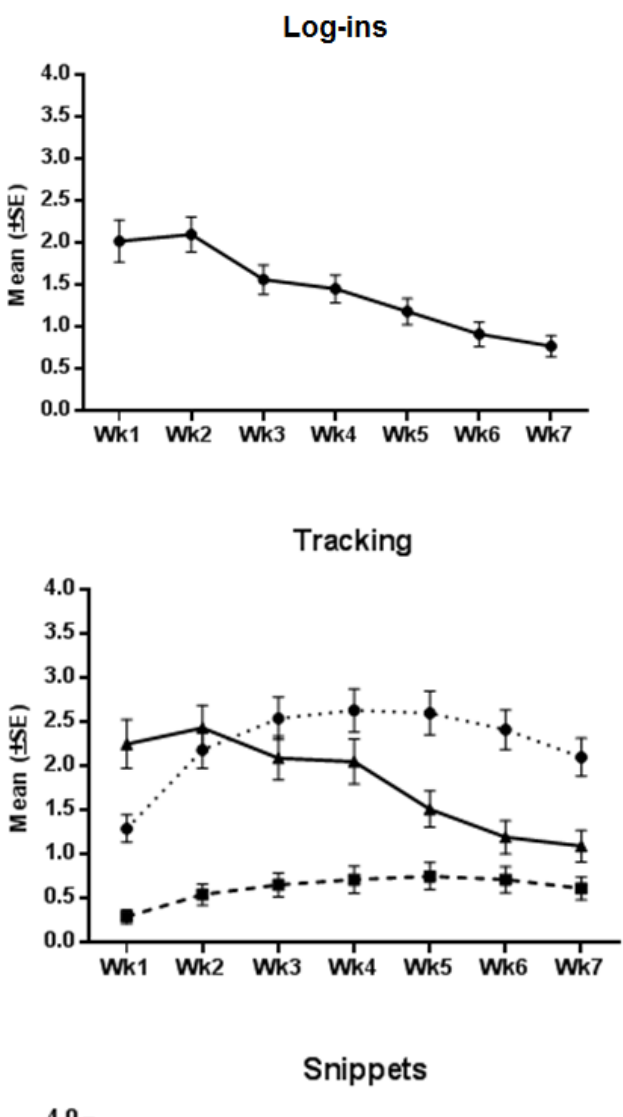
Figure 1. Use of program features across the intervention. SMS = short message service; Week =